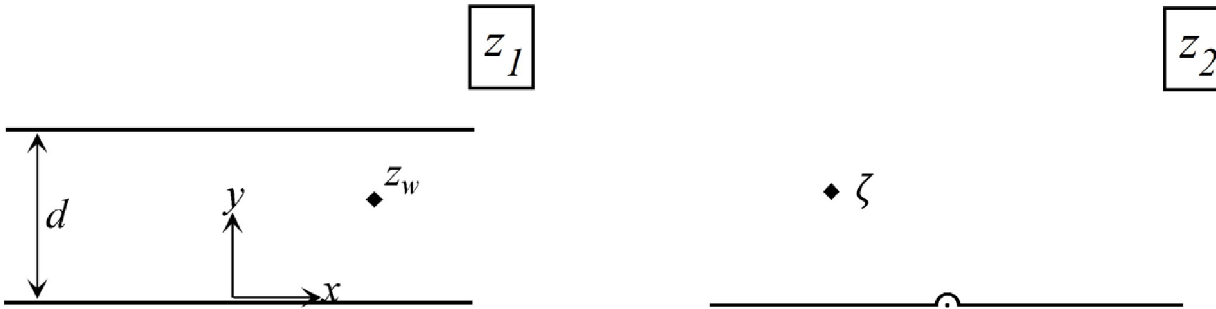
Fig 2. Mapping the conceptual model from the physical plane ( z 1 ) to the conformal mapping plane ( z 2 ).